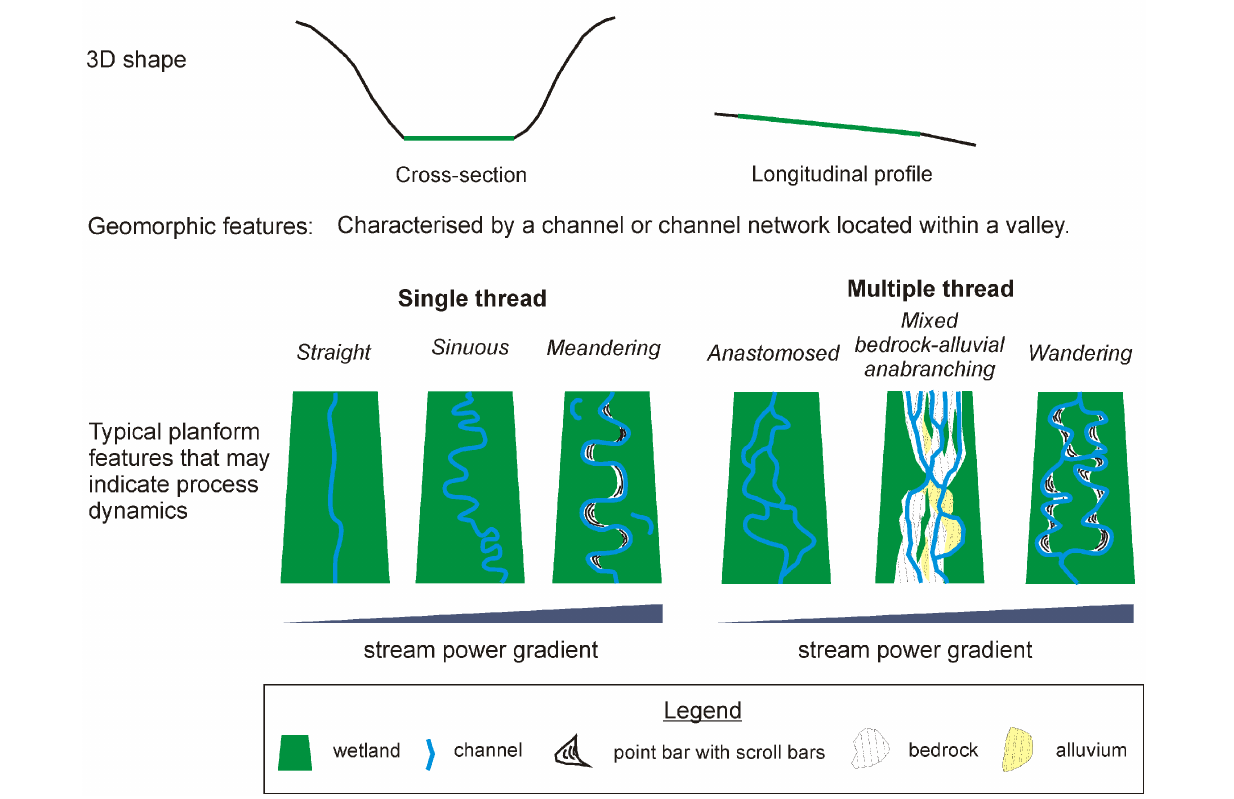
FIGURE 3 | Schematic shape and geomorphic features that are used to classify floodplain wetland type, followed by typical planform features that are used to classify sub-type.